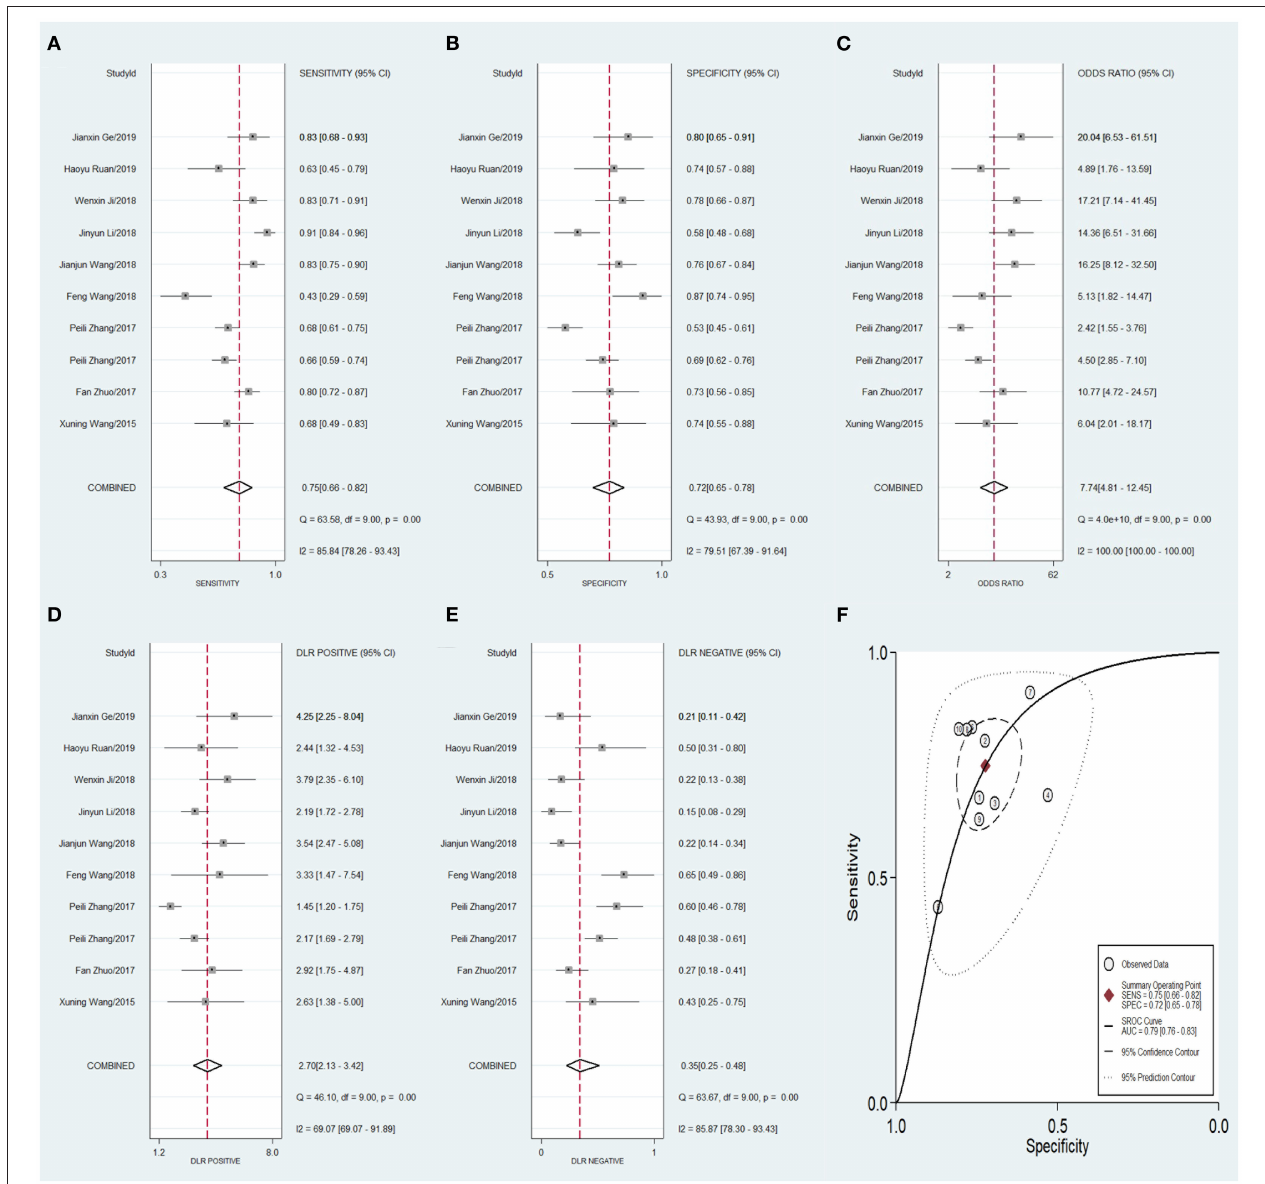
FIGURE 7 | Forest plots of pooled diagnostic power of down-regulated circRNA as a biomarker for colorectal cancer, (A) Sensitivity, (B) Specificity; (C) DOR; (D) PLR; (E) NLR and (F) AUC. DOR, diagnostics odds ratio; PLR, positive likelihood ratio; NLR, negative likelihood ratio; AUC, the area under receiver operating characteristics